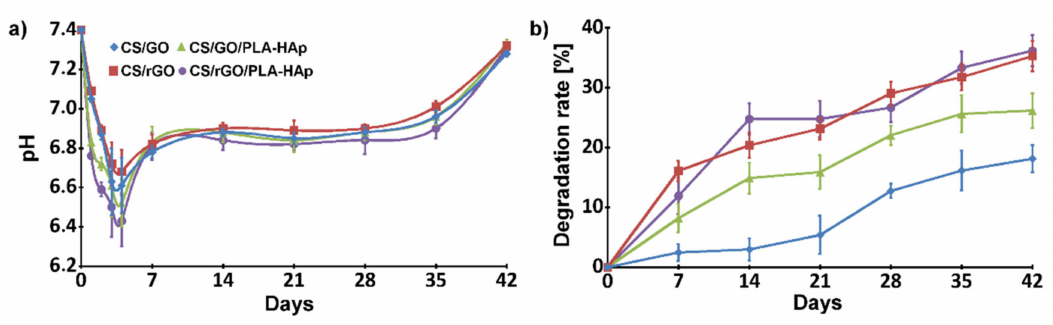
Figure 9. Degradation behavior: pH values of media ( a ) and weight loss of the samples ( b ) as a function of incubation time in